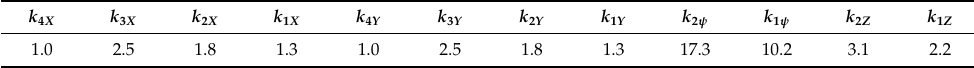
Table 2. The controllers